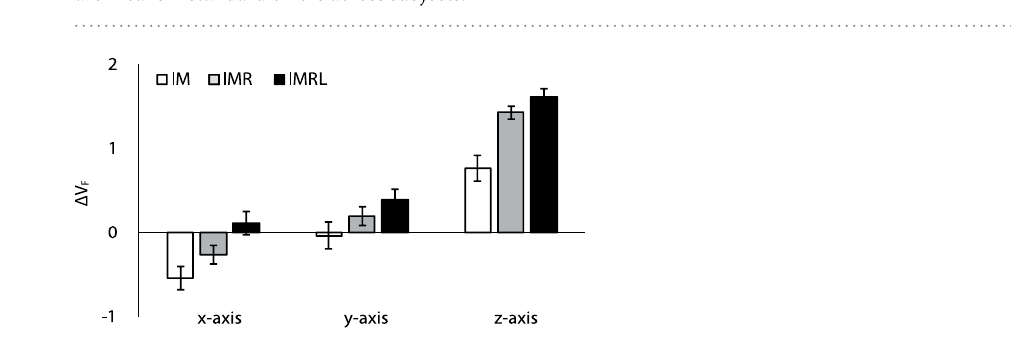
performance indices (e.g., ACI and PRI) across all individual subjects and conditions. For most cases, there were significant negative correlations between the synergy indices and performance variables (e.g., ACI and PRI) across subjects and conditions (i.e., the larger synergy indices, the better accuracy and precision). In particular, the coefficient of correlation ( r ) was larger in Δ V FZ vs. both ACI and PRI than in the synergy indices of the other axes vs. the performance indices ( Δ V F Z : r = − 0.63 for ACI, r = − 0.72 for PRI; Δ V F X : r = − 0.47 for ACI, r = − 0.39 for PRI; Δ V FY : r = − 0.35 for ACI, r = 0.06 for PRI, p < 0.05 for all comparisons except Δ V FY vs. PRI). Further, the three large points in Fig. 6 present the overall mean values of the synergy and performance indices across